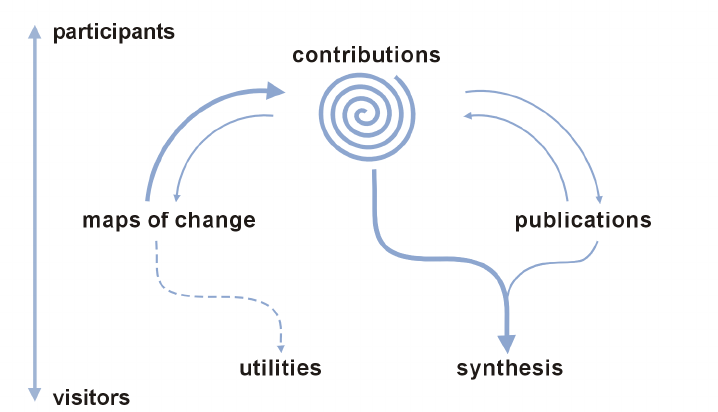
Figure 7. Schematic representation of the different components of the LechuSA initiative, indicating the flows of information and the different compromise of the scientific community (from visitors to participants of the